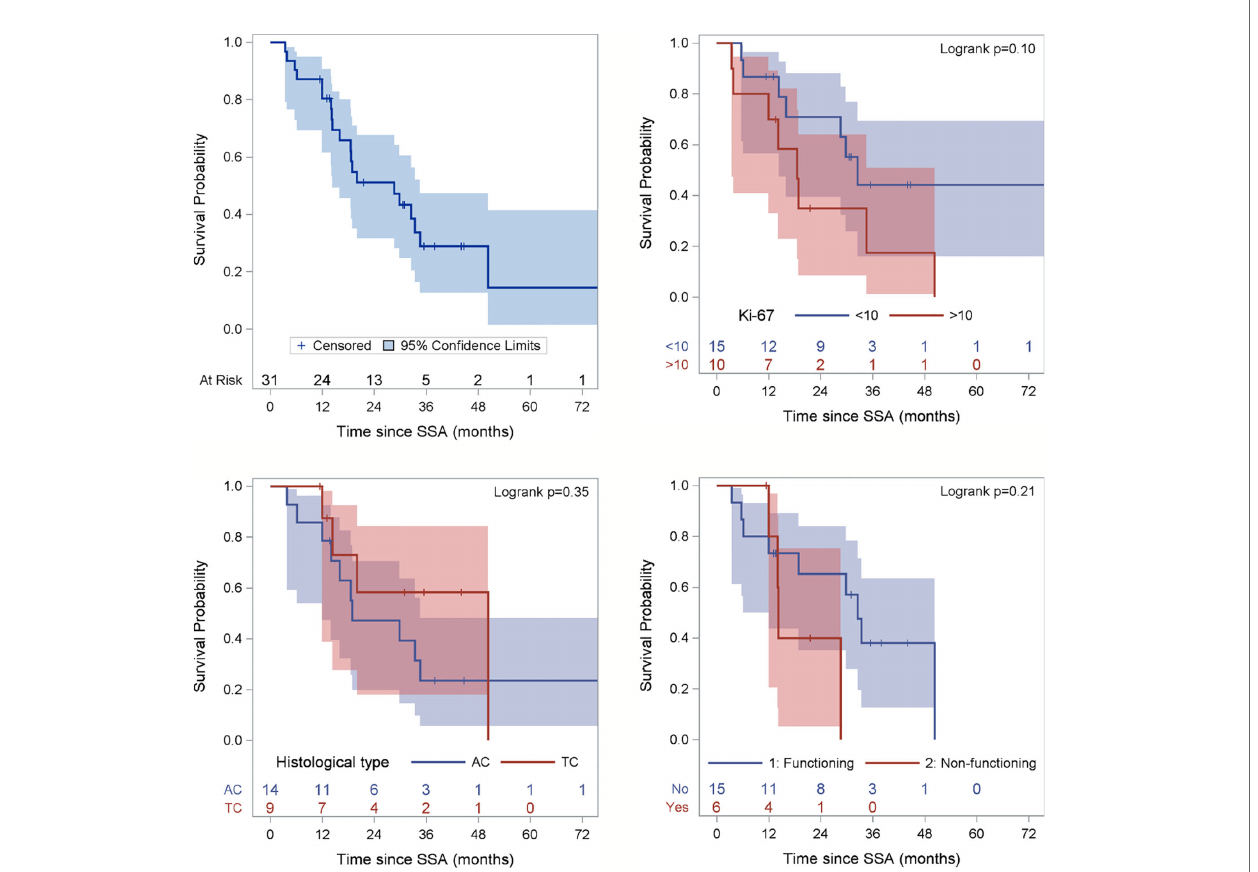
FIGURE 2 | Progression-free Survival (PFS) of the entire population and according to Ki67 category, histological subtype and functioning status. Ki67 is missing for 6 patients and functioning status for 10 patients. Figure for histological type excludes 2 patients with NEN, 2 carcinoid tumors not otherwise speci fi es (NOS) and 5 well-differentiated NETS.